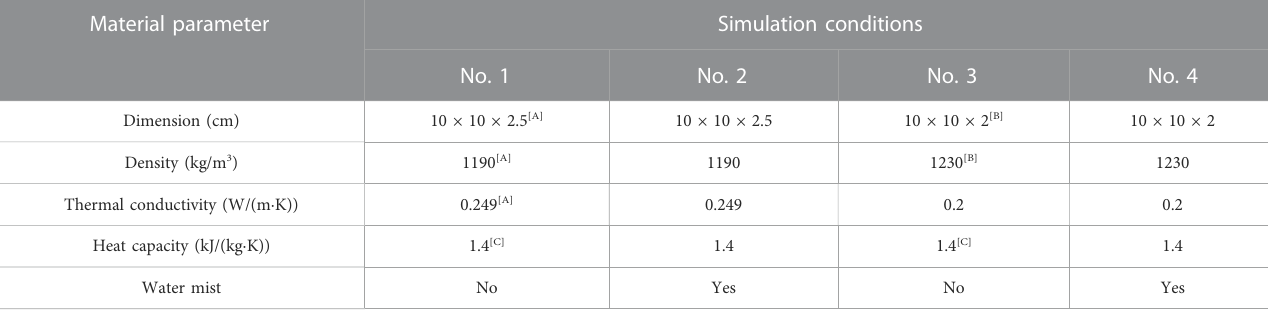
TABLE 1 Material property parameter of PMMA